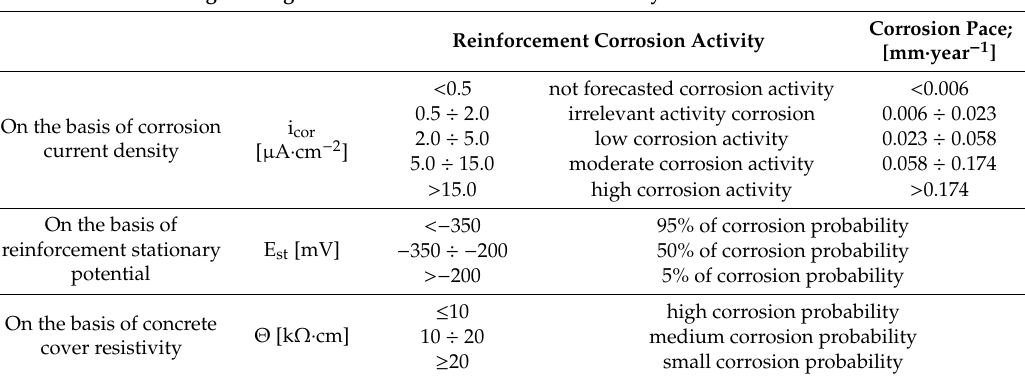
Table 3. Criteria for assessing the degree of reinforcement corrosion